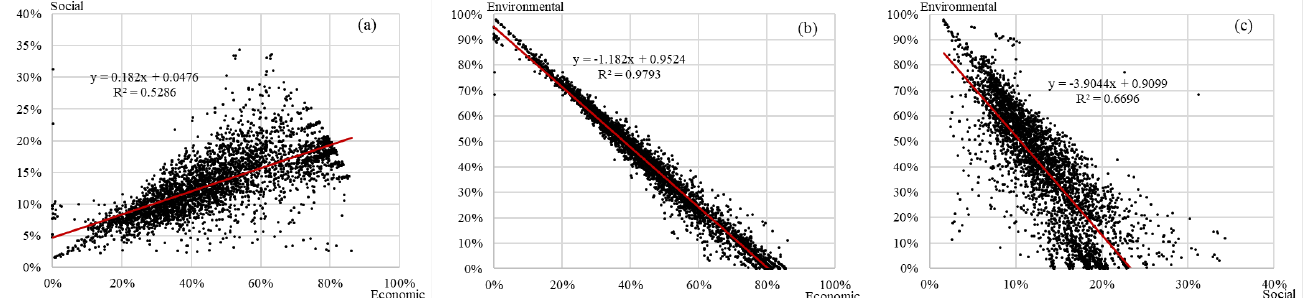
Figure 5. Relationship of three dimensions of land use functional values. ( a ): Relationship between social and economic functions; ( b ): Relationship between environmental and economic functions; ( c ): Relationship between environmental and social functions. The red lines are linear fit lines.